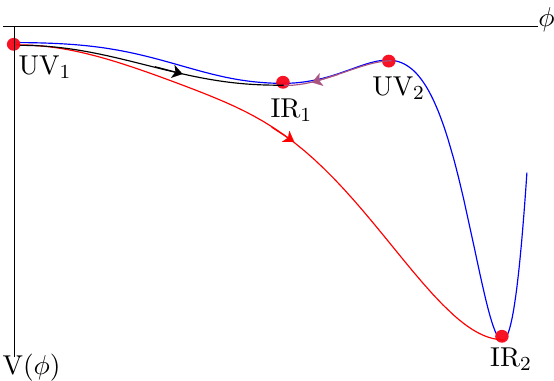
Figure 1 . Schematic plot of the potential which allows skipping solutions, with a representation of the corresponding zero-temperature RG (cid:13)ows connecting di(cid:11)erent (cid:12)xed points. well-de(cid:12)ned vacuum with j > 0. This is not uncommon in perturbative (cid:12)eld theory,